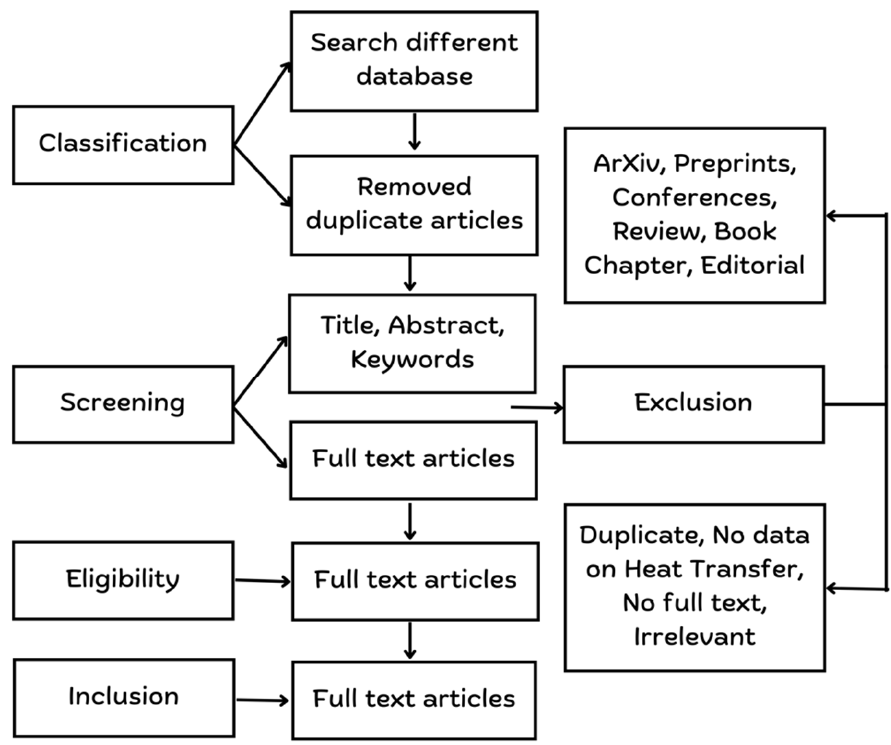
Figure 1. Flow chart of the study selection process.